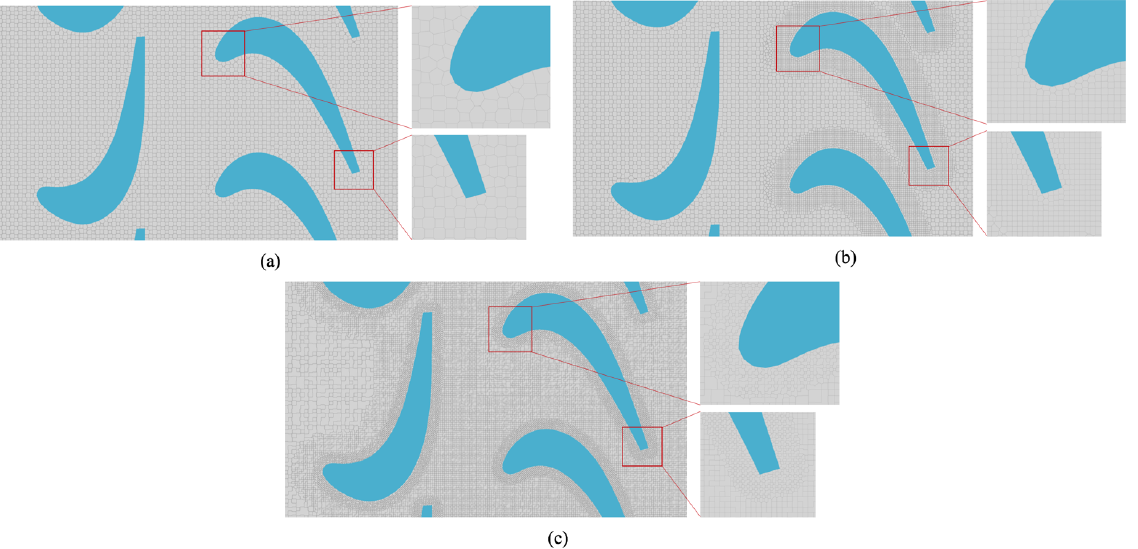
Figure 6. Visualization of generated Voronoi meshes in the stator–rotor region for three different resolutions: ( a ) Grid A (coarse); ( b ) Grid B (medium); and ( c ) GridC